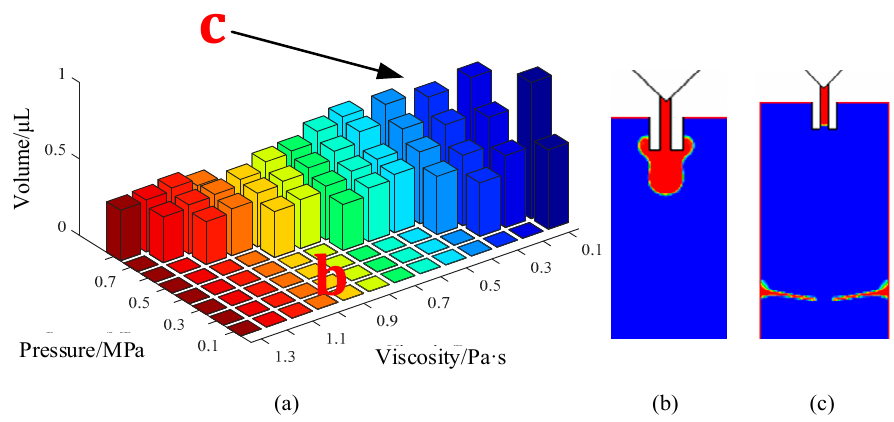
Figure 9. The comprehensive influence of pressure and viscosity on the droplet volume and morphology: ( a ) Jetting volume; ( b ) adhesion phenomenon; ( c ) satellite dots. Conditions: The nozzle diameter is 0.2 mm, the needle stroke is 0.3 mm, the frequency is 20 Hz, and the surface tension is 0.03 N/m.